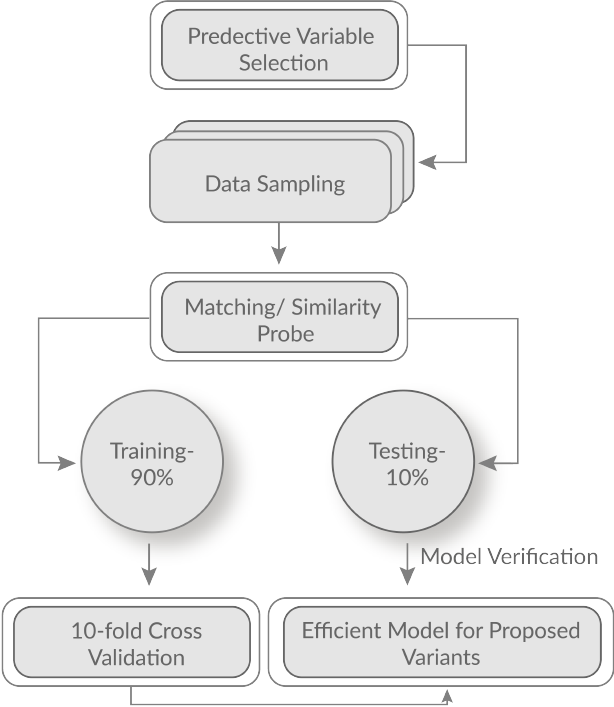
Figure 6. Optimal perdition model for conducting the